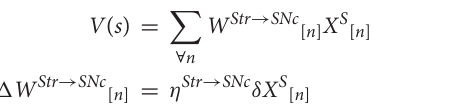
These weights from the striatum to SNc ( W Str → SNc ) are trained using the signal from SNc which is representative of Temporal Difference (TD) error ( δ ) (Equation 6). The TD error is calculated as δ = r + γ V ( s ′ ) − V ( s ) where s ′ is the new state after taking action a (Equation 19), r is the reward obtained and γ is